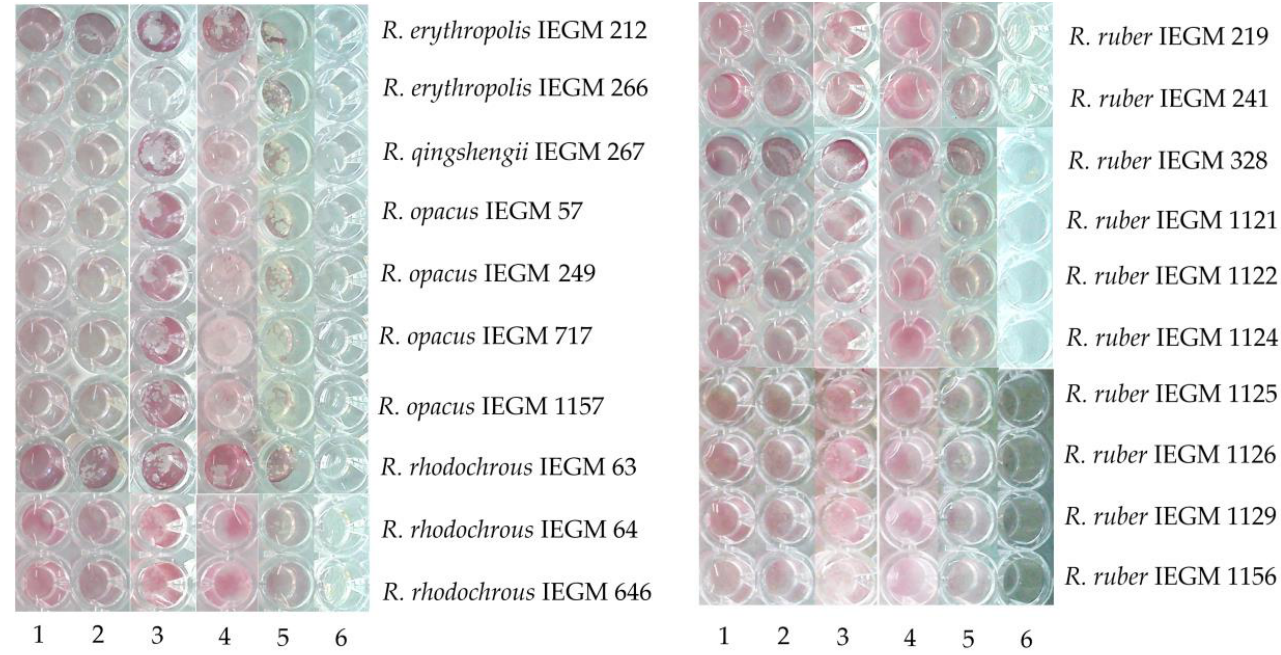
Figure 4. Growth of Rhodococcus spp. in the mineral medium RS with 25 mM PAHs: 1—naphthalene, 2—phenanthrene, 3—anthracene, 4—benzo[a]anthracene, 5—benzo[a]pyrene, 6—control for oligotrophic growth (RS without growth substrates). Cells are stained with 0.2% INT. The appearance of red-purple color is evidence of the presence of viable and metabolically active cells. Table 2. Growth of selected Rhodococcus strains in the presence of phenol and pyridine. Number of Strains Species Total Growing Not Growing